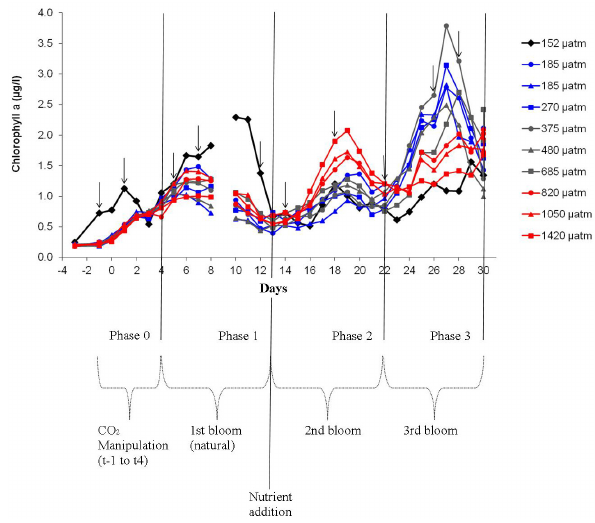
Fig. 1 . Chlorophyll a ( µ g/l) concentrations measurements plotted against days, where arrows Fig. 1. Chlorophyll a (µgL − 1 ) concentration measurements plotted marked time points analysed in the present study. Figure derived from Schulz et al. (2012). against days, where arrows mark time points analysed in the present study. Figure derived from Schulz et al.